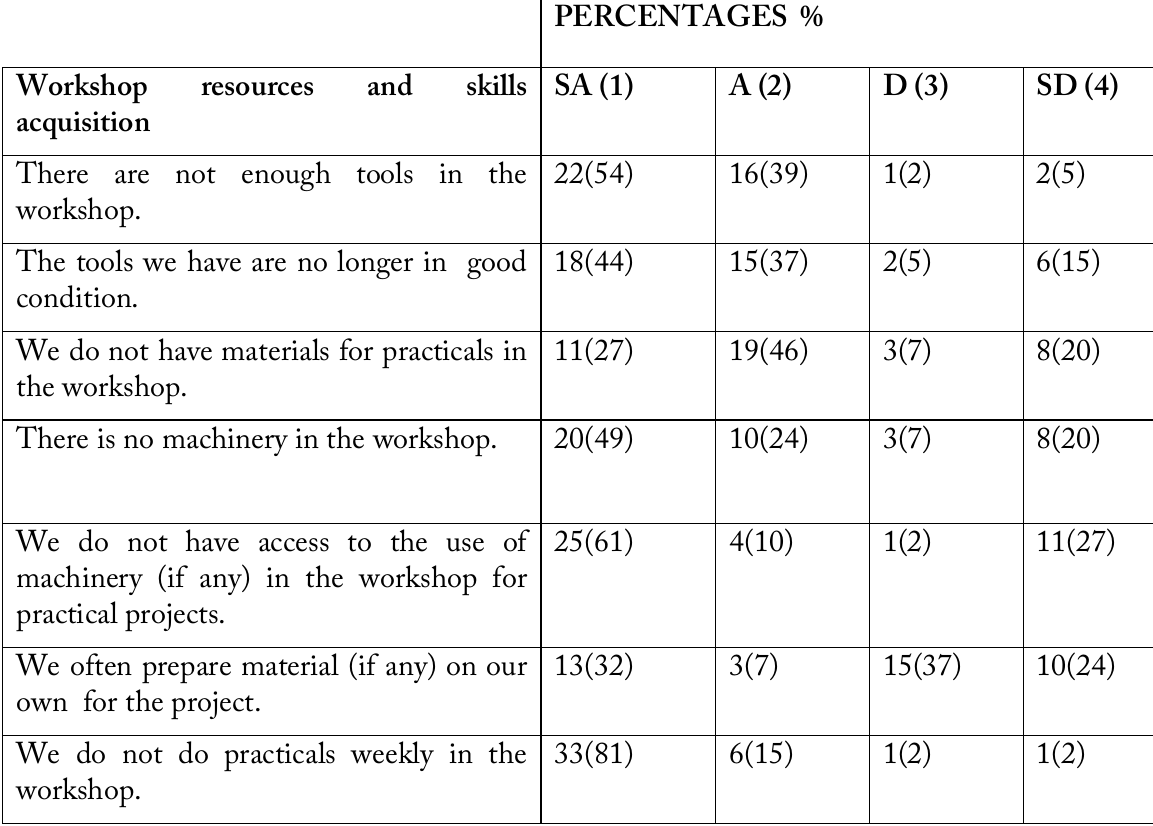
Table 1: Workshop resources and skills acquisition as viewed by